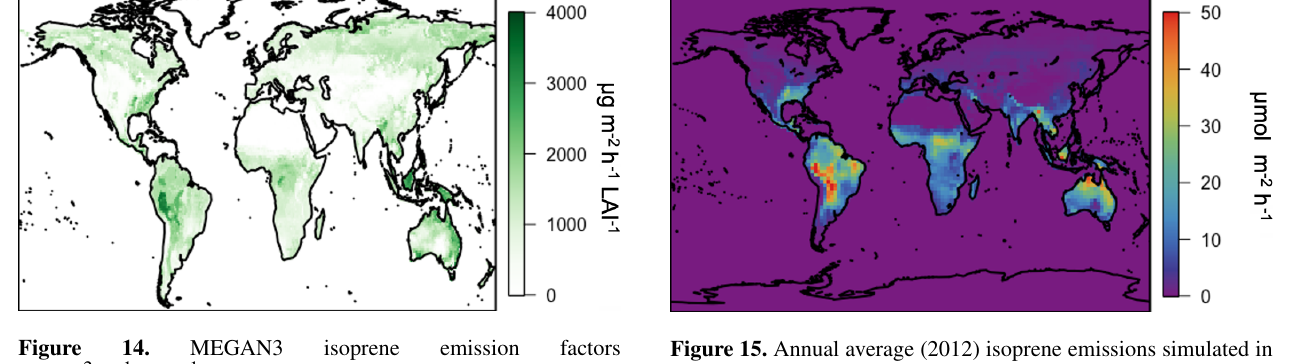
Figure 15. Annual average (2012) isoprene emissions simulated in GEOS-Chem driven by the surrogate model canopy physics and the MEGAN3 emission and activity